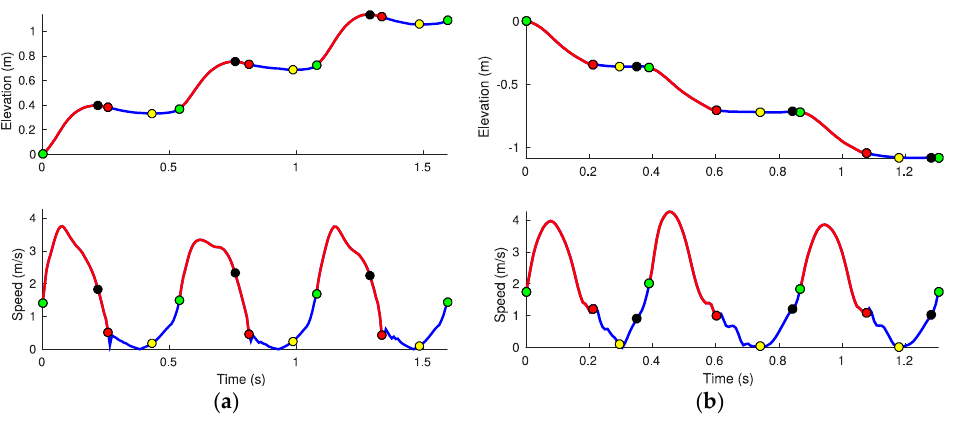
Figure 5. Estimated foot trajectory and speed for running over three treads during ascending ( a ) and descending ( b ). Close up of a steady state running gait showing the major stride events times: toe-off t of f (green dots), foot strike t strike (red dots), maximum elevation t max (black dots), minimum elevation t min (yellow dots); and gait phases: stance phase t stance (blue curves) and swing phase t swing (red